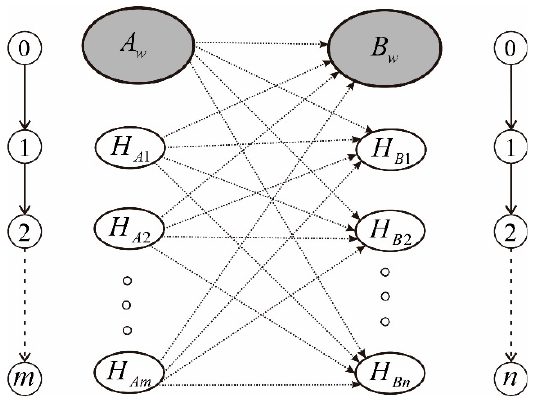
Figure 4. Intersection orders of intersecting components in elements of R G 9 IM . Therefore, R 11 , R 12 , R 21 , and R 22 of R G 9 IM are composed of ( m + 1 )( n + 1 ) intersecting components; R 13 and R 23 are composed of ( m + 1 ) intersecting components; R 31 and R 32 are composed of ( n + 1 ) intersecting components; R 33 is composed of one intersecting component. For the purpose of expressing the elements in R G 9 IM and their unity of forms, we extended the five-bit binary code proposed by OUYANG et al. (2009) [20] to the ( m + 1)( n + 1)-bit binary code to represent the value of each element R ij ( 1 ≤ i , j ≤ 3 ) in R G 9 IM . Values of each element in R G 9 IM are shown in Table 2. X 0 corresponds to the first intersecting component, that is, the corresponding intersecting component of A w and B w . X 1 corresponds to the second intersecting component, that is, the corresponding intersecting component of A w and H B 1 . X 2 corresponds to the third intersecting component, that is, the corresponding intersecting component of A w and H B 2 . In turn, X mn + m + n corresponds to the ( m + 1) ( n + 1)th intersecting component, that is, the corresponding intersecting component of H Am and H Bn . Table 2. Intersecting components in elements of 9 G IM R . X … 0 o o H B A … … o B … 1 A w Bn A w